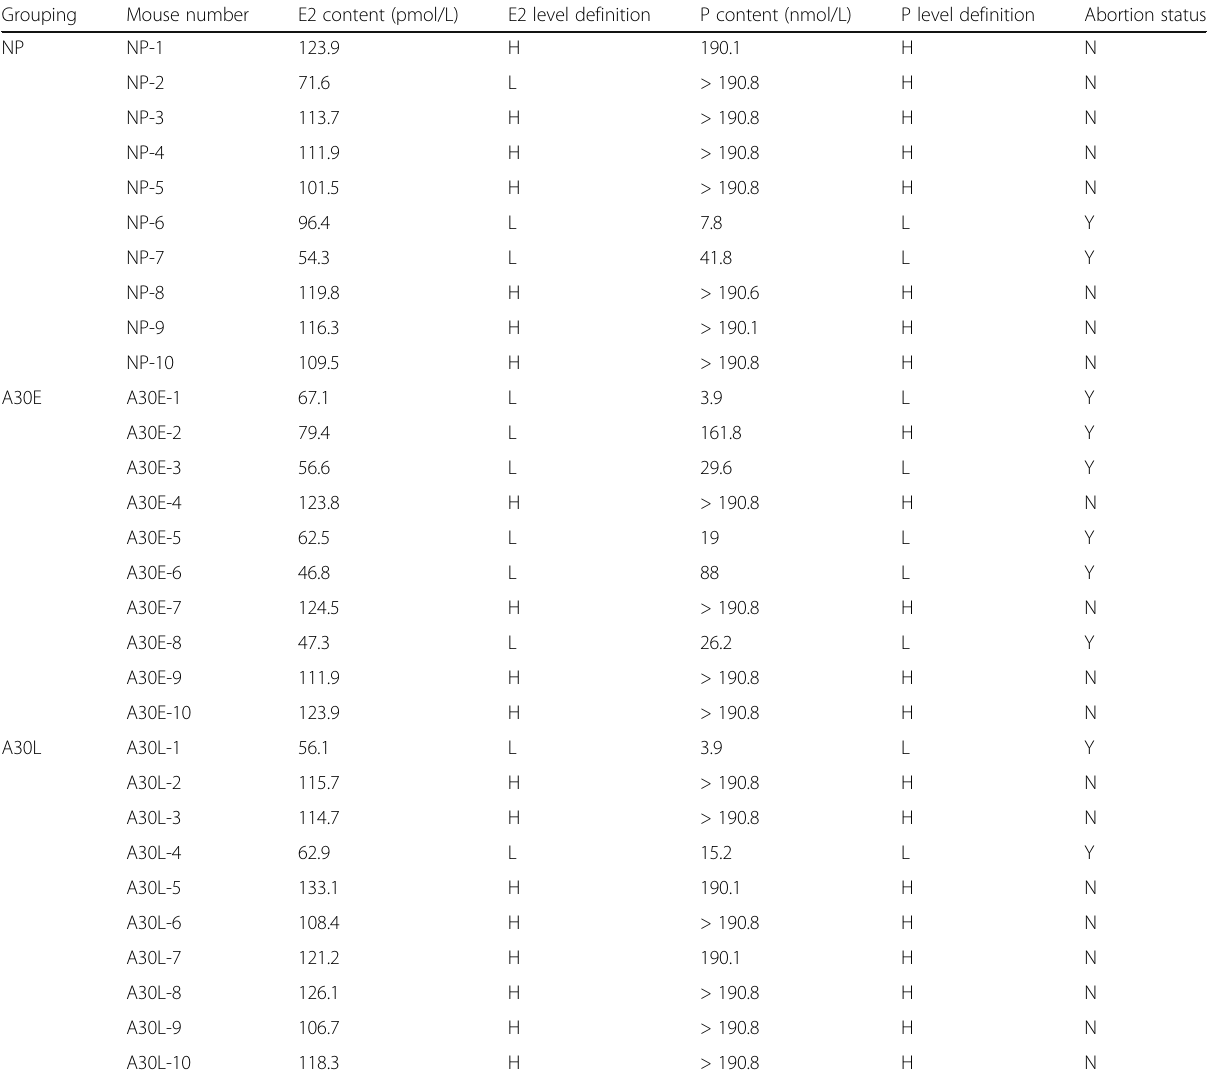
Table 4 Estrogen serum concentration and level of aborted or non-aborted pregnant mice